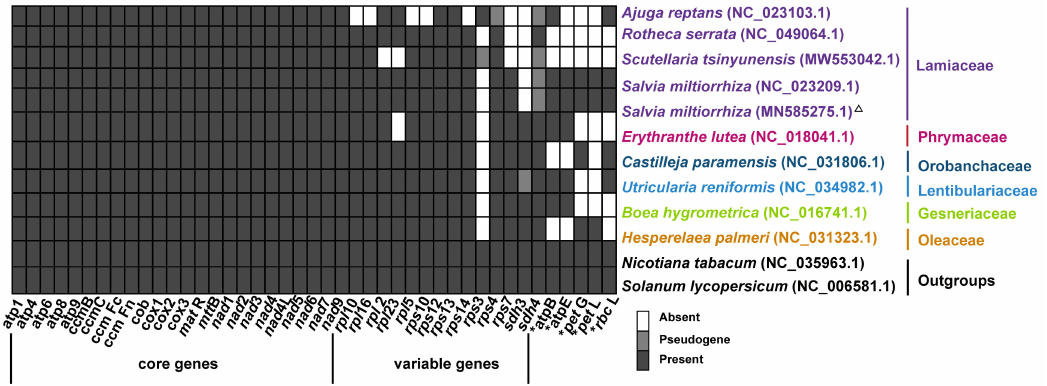
Figure 3. PCG contents in nine sequenced Lamiales mitogenomes. The X-axis shows the name of core and variable genes. Five PCGs, namely, atpB , atpE , petG , petL , and rbcL , were similar to the sequences from plastomes (labeled with “*”). The mitogenome generated in this study was labeled with the triangle. The species belonging to Lamiaceae , Phrymaceae , Lentibulariaceae , Gesneriaceae , and Oleaceae were labeled with the colors of purple, peach, dark green, blue, green, and orange,